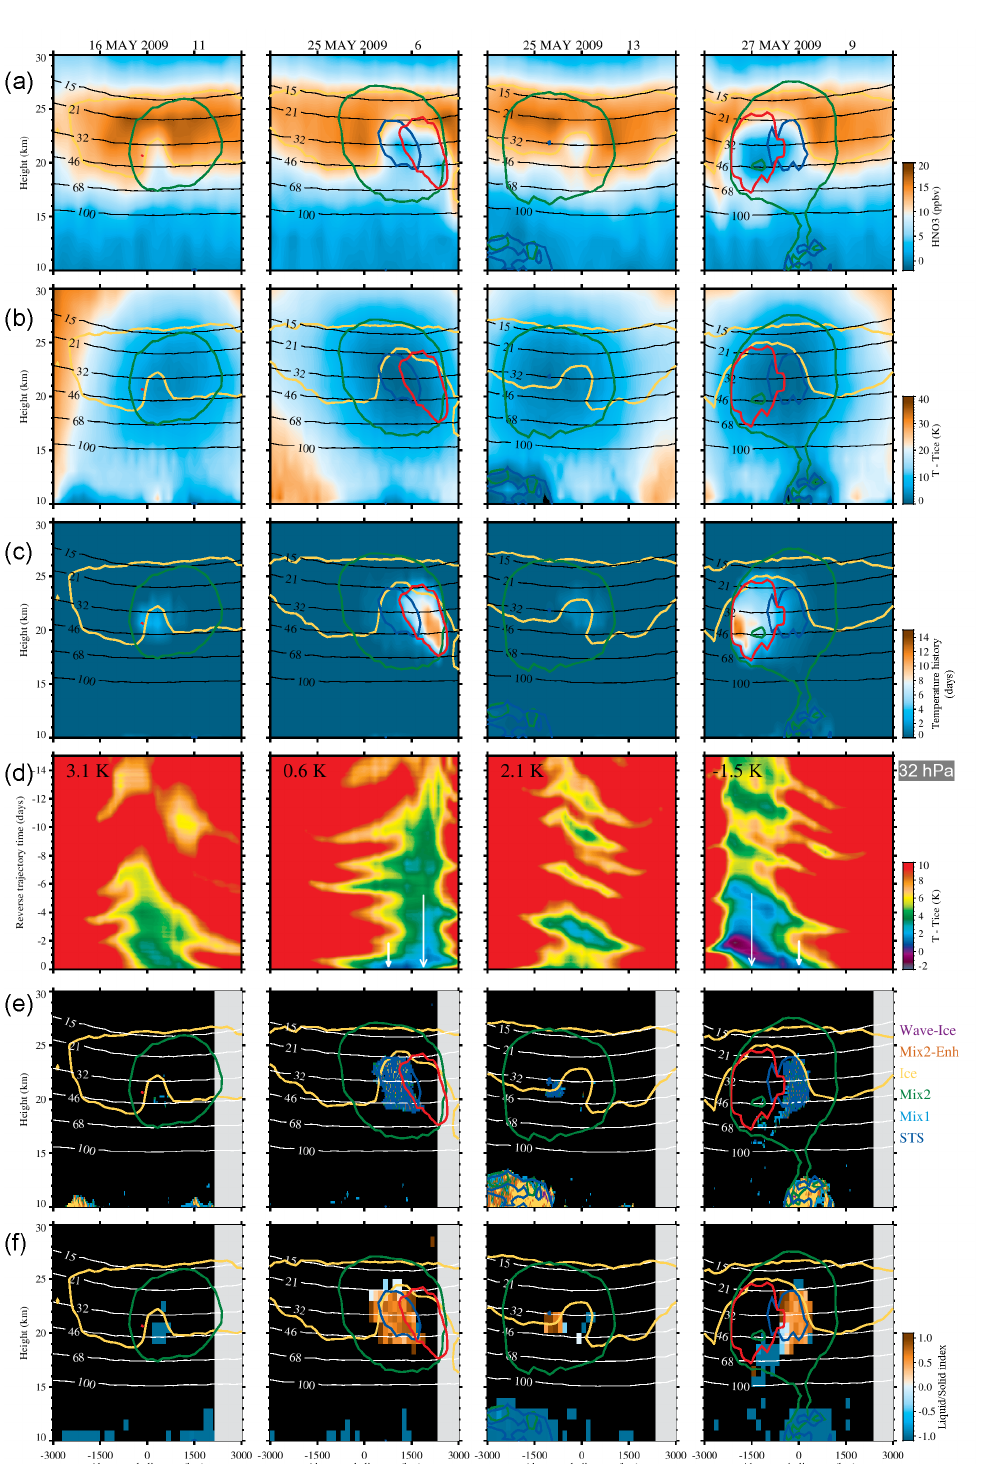
Figure 8. Co-located MLS and CALIOP orbit transects for selected orbits showing in six rows: (a) MLS HNO 3 . (b) Ambient temperature, T − T ICE . (c) Temperature threshold exposure, TTE (days). (d) Fifteen-day reverse trajectory temperature history, T − T ICE , ending at the 31hPa pressure level. Minimum temperature encountered along the trajectory is inset at the top left. (e) CALIOP L2PSCMask PSC classification. (f) LS_index . MLS pressure levels are shown as labeled black or white contours. Blue (green) contours indicate T ICE + 2K ( T NAT ). Red contours indicate TTE values ≥ 3 days. The MLS 12ppbv HNO 3 contours are indicated in yellow. Gray shading in (e, f) indicates that the CALIOP observations are in